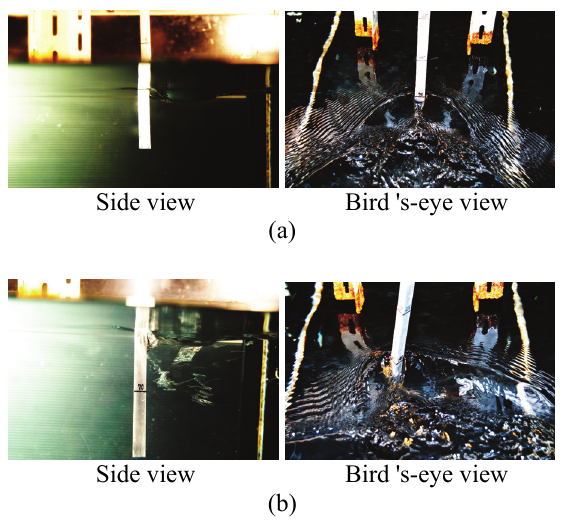
Fig. 9. Flow feature around triangular cylinder, (a) sharp triangular cylinder (S. T.), draft; 70 mm, flow velocity; 0.6 m/s, (b) Flat triangular cylinder (F. T.), draft; 140 mm, flow velocity; 0.6 m/s